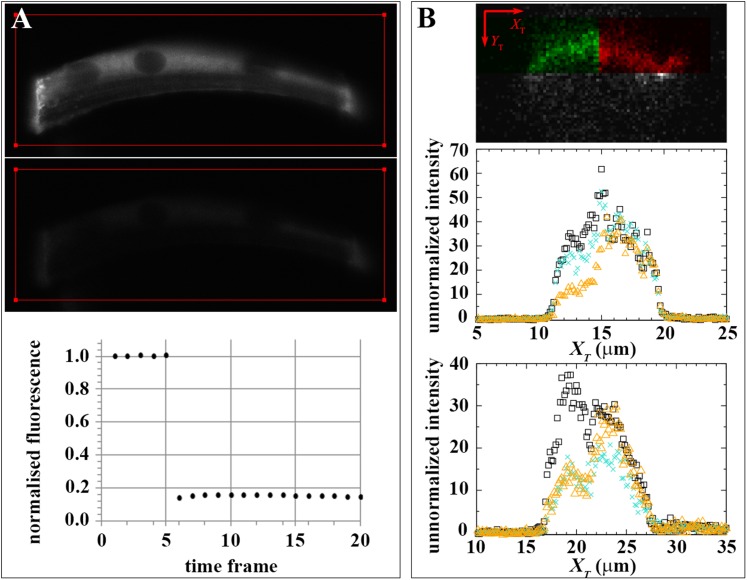
Effect of dark state and lateral mobility on huDysGFP intensity recovery.(A) To evaluate the recovery fraction due to dark state, huDysGFP was bleached in entire muscle fibres in vivo. Images shown were taken at t = 0 (top panel) and right after bleaching (middle panel); the red line defines the bleached region. Lower panel: plot of normalised fluorescence shows very low recovery after photobleaching (0.6%), presumably due to a shift from dark state to excitable huDysGFP. (B) FRAP tests for lateral mobility of bound huDysGFP. Top panel: initial image acquired from muscle fibre tip 7 showing the area to be bleached in green and the unbleached tip region in red. Middle and bottom panels: one-dimensional profiles along XT for an example of substantial recovery (middle panel, tip7) and little recovery (bottom panel, tip27). Profiles are shown at three time points: before deliberate bleaching (t = 0.93 s, black squares), just after bleaching (t = 5.3 s, orange triangles), and at the end of the experiment (t = 230 s, turquoise crosses). The intensity at each point is the average (background corrected) unnormalized intensity over the 20 pixel strip along the YT axis and averaged over 3 images, at the given time, plus the previous and next images.